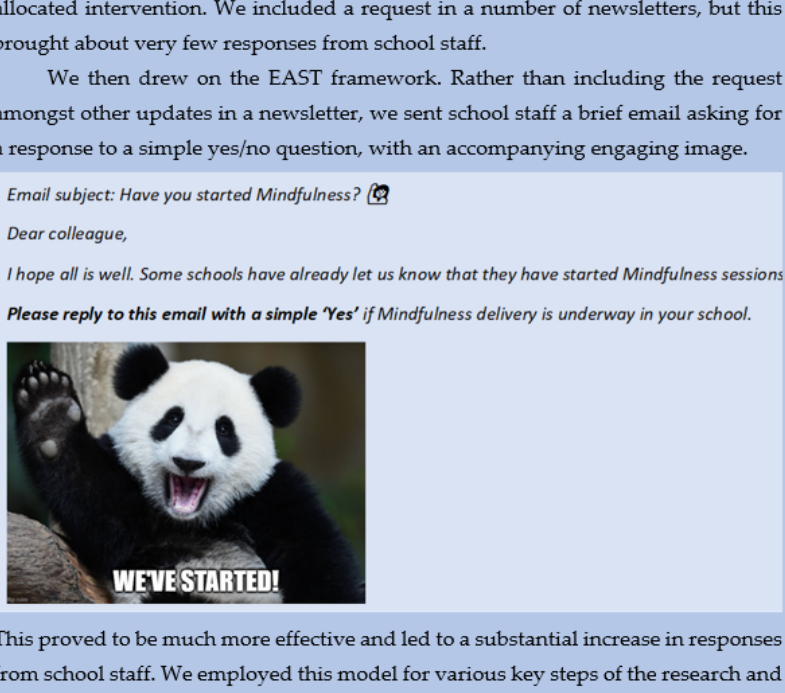
Figure 1. Spotlight on Eliciting Email Responses. Panda image: V-yan (Photographer) A playful happy panda in China (digital image) retrieved from https://www.shutterstock.com/image-photo/playful-happy-panda-china-1390386575 (accessed on 10 January 2022).